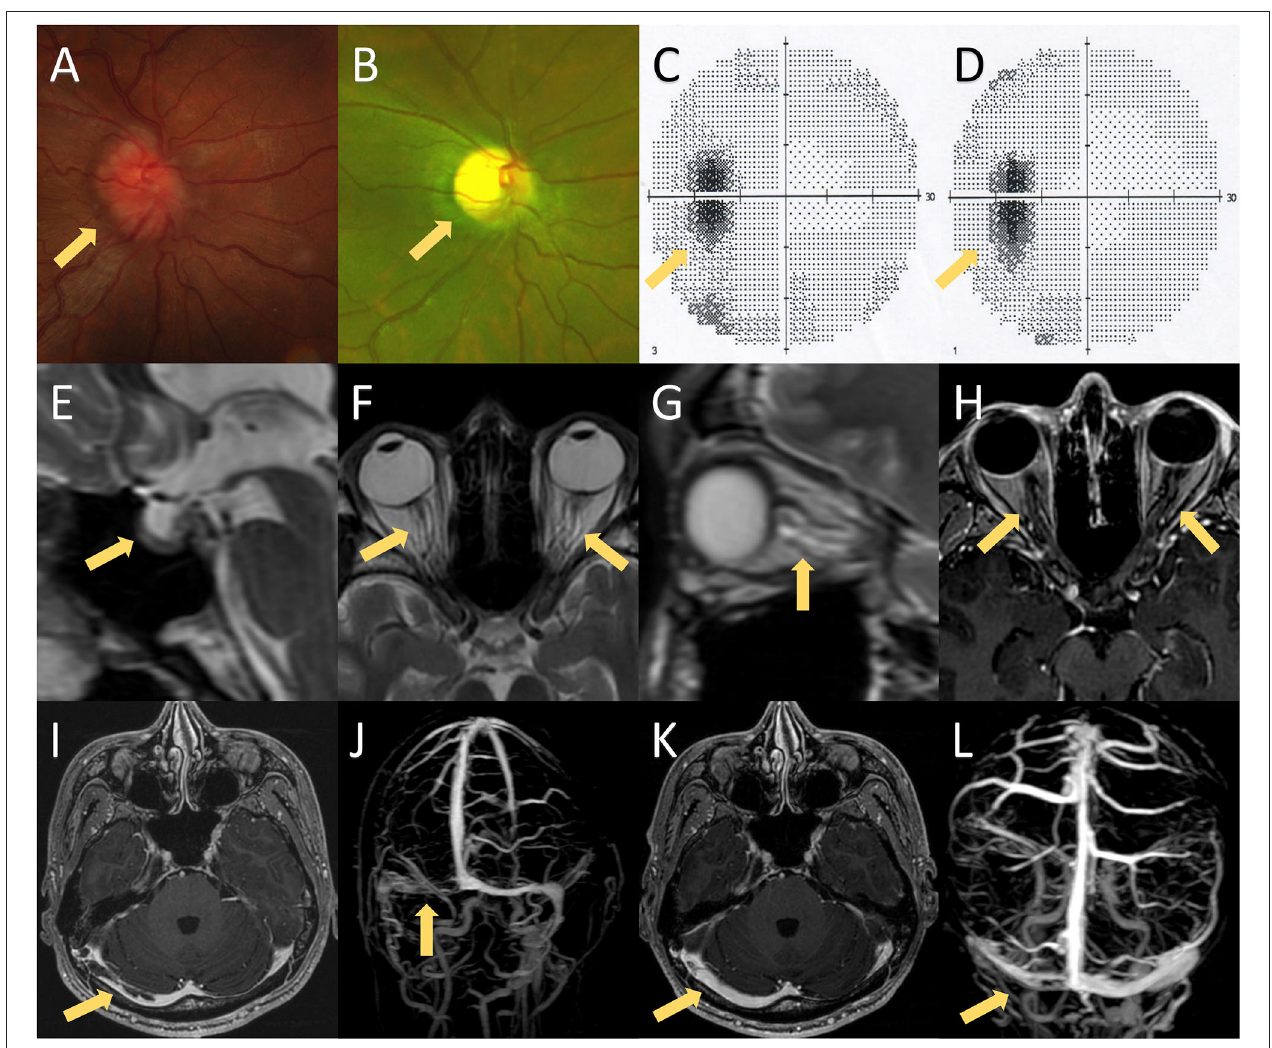
FIGURE 1 | MRI findings, fundoscopic findings, and visual fields of the presented case. (A) Fundoscopic examination on the first hospitalization showed bilateral papilledema. (B) Fundoscopic examination on the second hospitalization revealed bilateral optic atrophy, which was probably caused by bilateral papilledema. (C,D) Visual fields on the first and second hospitalizations showed bilateral enlargement of the physiological blind spot without any other visual field defect. (E–G) Brain MRI exhibited several imaging signs of intracranial hypertension, including the empty-sella sign (E) , perioptic subarachnoid space distension (F,G) , optic nerve tortuosity (G) , and posterior globe flattening (F,G) . (H) Brain MRI with contrast showed no enhancement of the optic nerve. (I,J) Post-contrast 3D GRE T1-weighted imaging and contrast-enhanced magnetic resonance venography (CE-MRV) showed filling defects of the right transverse-sigmoid sinus. (K,L) Brain MRI and CE-MRV after 3 months of anticoagulation showed partial recanalization of the right transverse-sigmoid